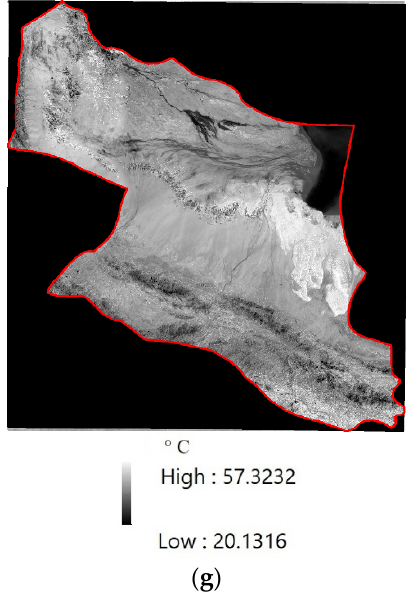
Figure 3. Sample data from Qaleh-Ganj County (Red Boundary) acquired in April 2020. ( a ) RGB true color; ( b ) ET; ( c ) Precipitation; ( d ) SSM; ( e ) SUSM; ( f ) NDVI; ( g ) LST.